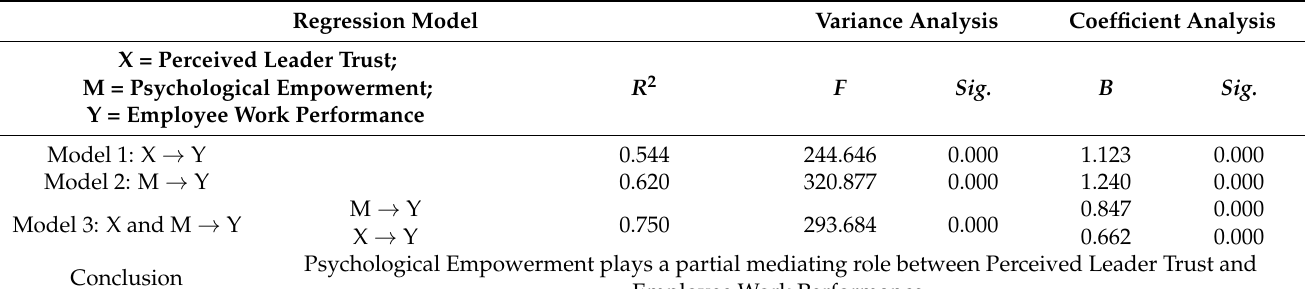
Table 26. Test of the Mediating Effect of Psychological Empowerment between Perceived Leader Trust and Employee Work Performance.